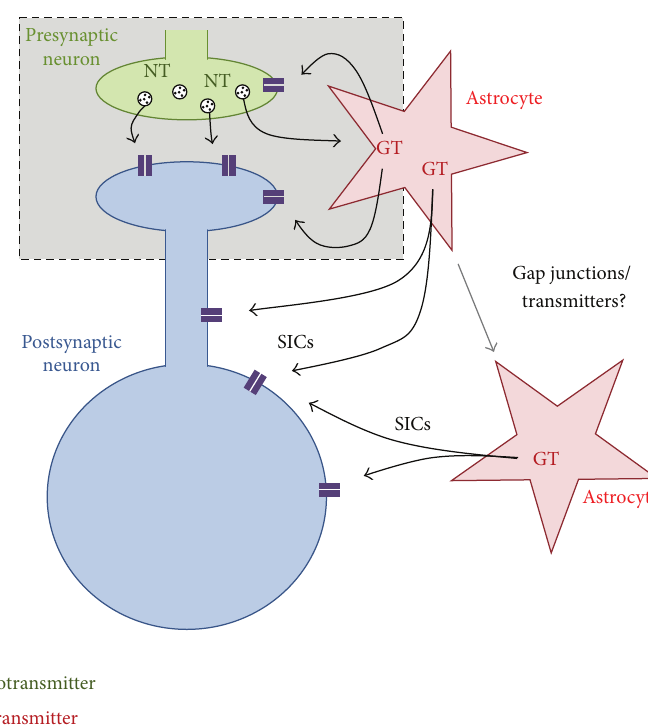
Figure 4: A schematic of astrocyte-neuronal signalling. The grey box represents the tripartite synapse system; astrocytes sense neuro- transmitter release and respond with release of gliotransmitter at the synapse. Astrocytes also release glutamate to activate extrasynaptic NMDA receptors, which can undergo long term enhancement (LTE) with synaptic activity. Extrasynaptic release may derive from astrocytes ensheathing the synapse and possibly through recruitment of other astrocytes in a network. SICs: slow inward currents; NT: neurotransmitter; GT: